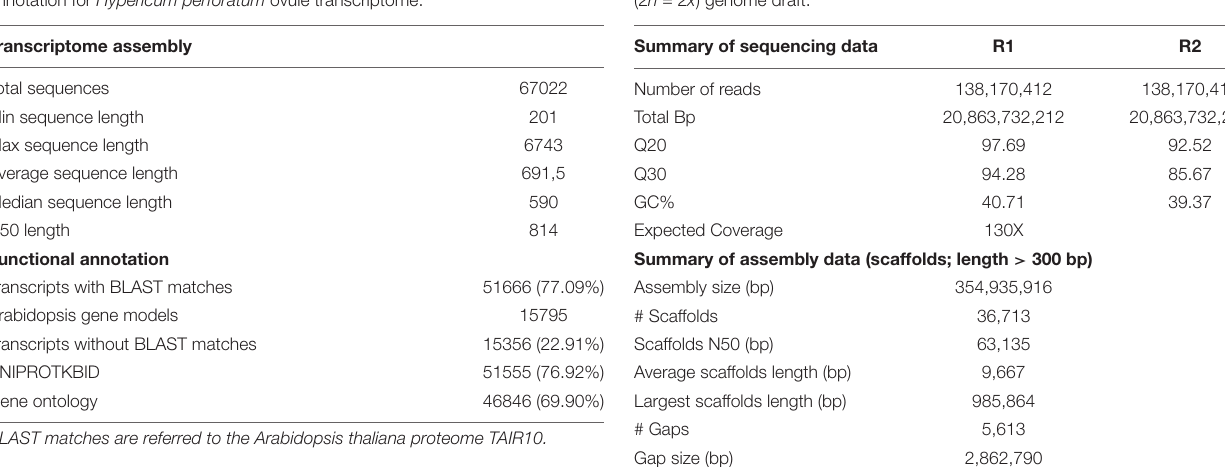
TABLE 2 | Summary of sequencing and assembly data for the H. perforatum (2 n = 2 x ) genome